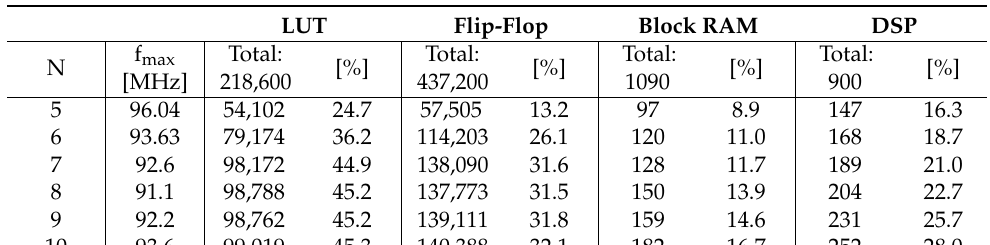
Table 1. Utilization report of the implemented design for individual FPGA primitives. The target